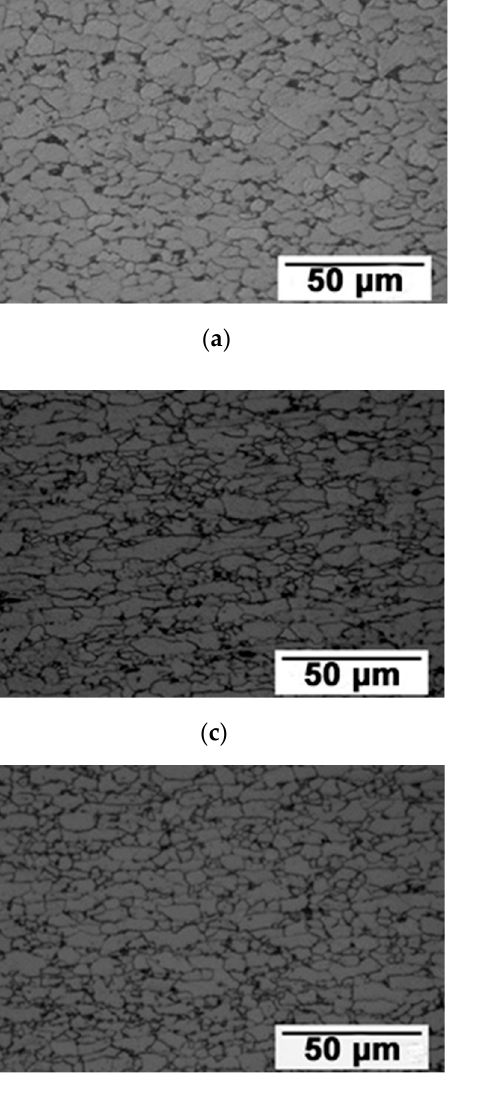
Table 4. Grain size in the test samples.